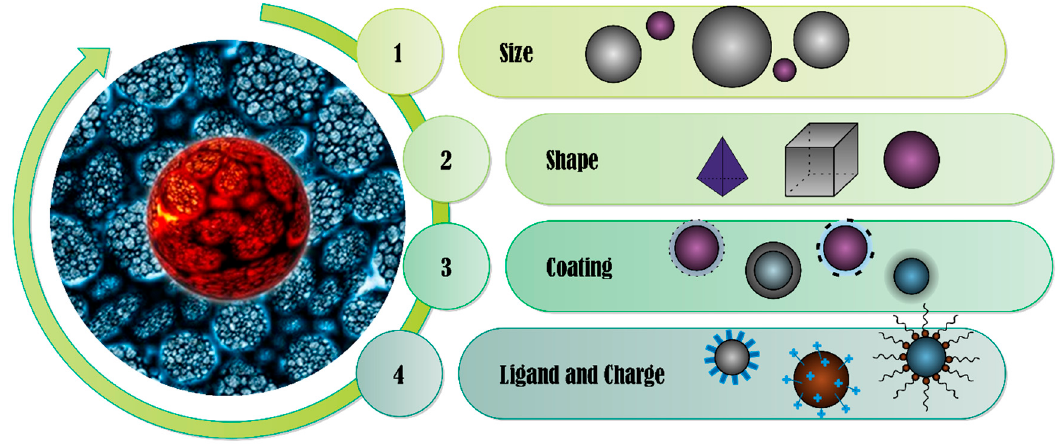
Figure 2. The main properties of nanoparticles affecting their toxicity.